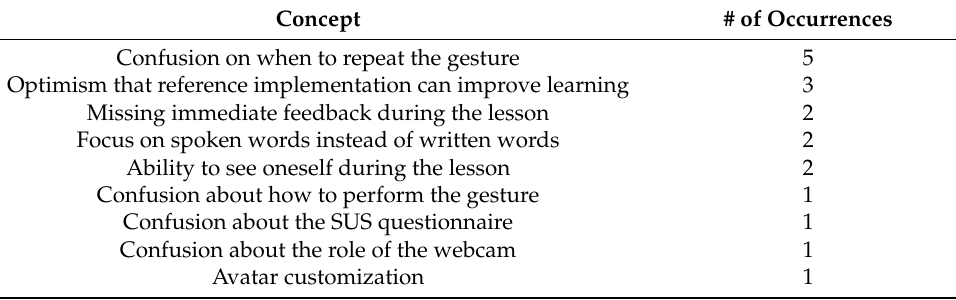
Table 1. Occurrences of concepts in the free-text